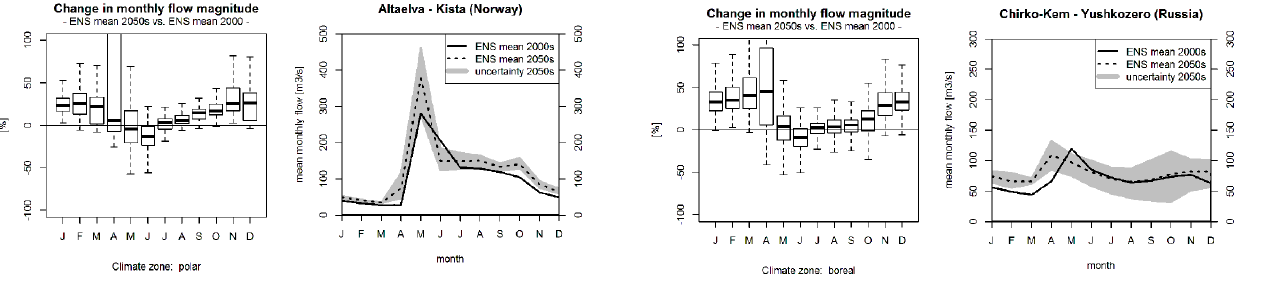
Fig. 9. Direction of change in the 2050s plotted for all grid cells of the boreal climate zone (left) and the Chirko-Kem river near Yushkozero